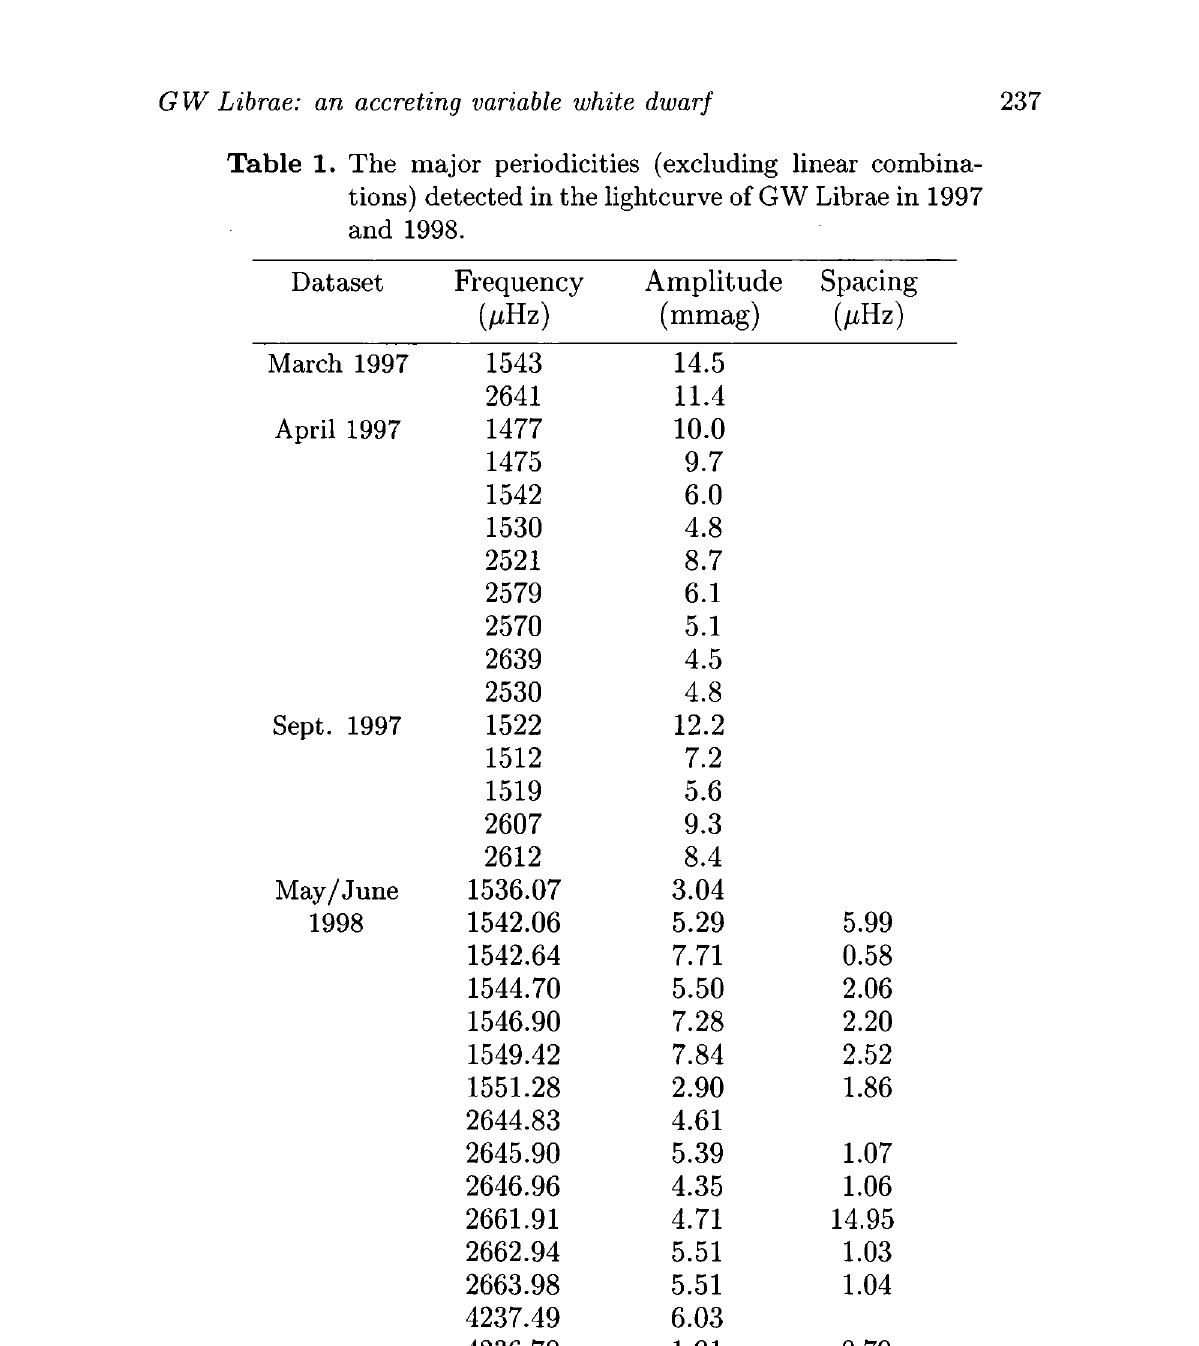
Table 1. The major periodicities (excluding linear combina- tions) detected in the lightcurve of GW Librae in 1997 and